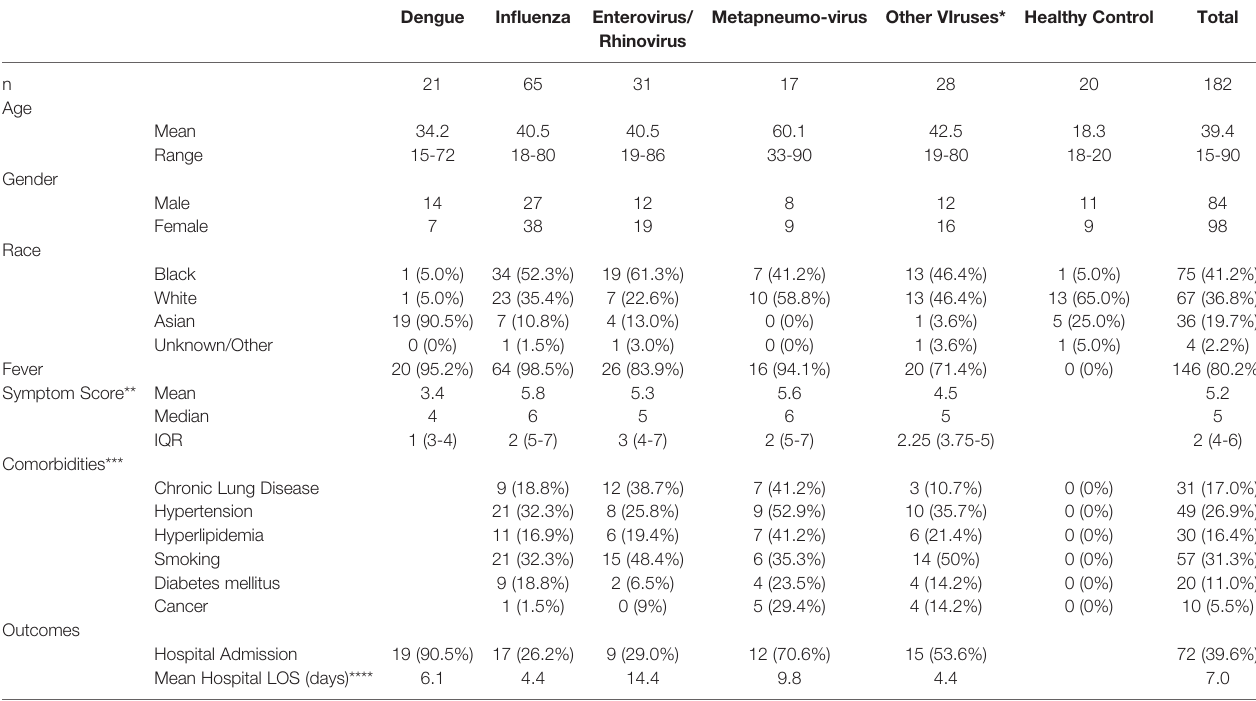
TABLE 1 | Demographics and clinical characteristics of study